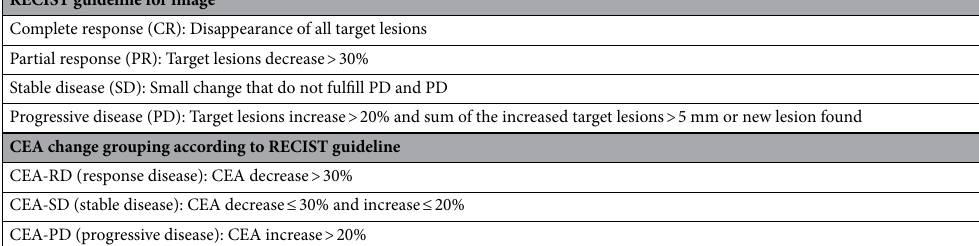
Tumor differentiation